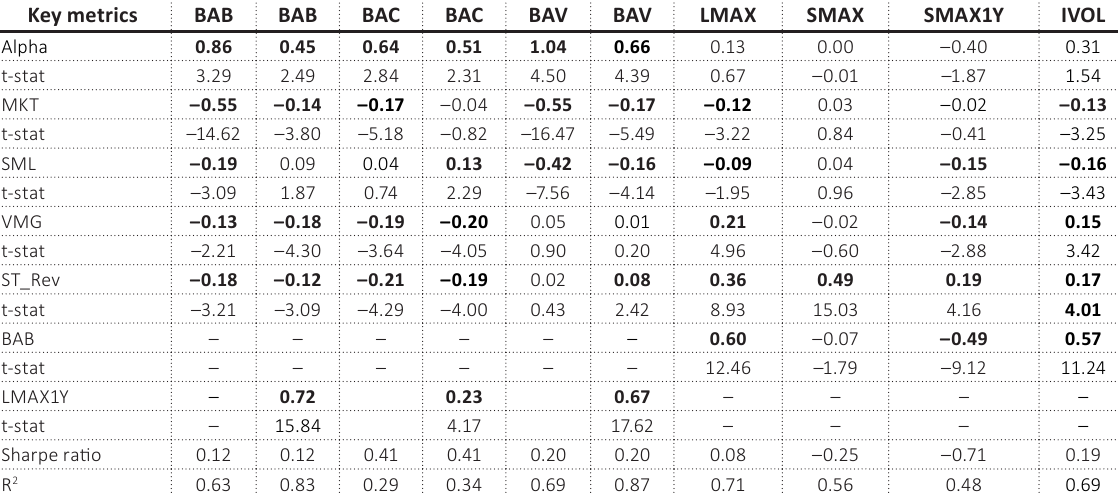
Source: Author’s